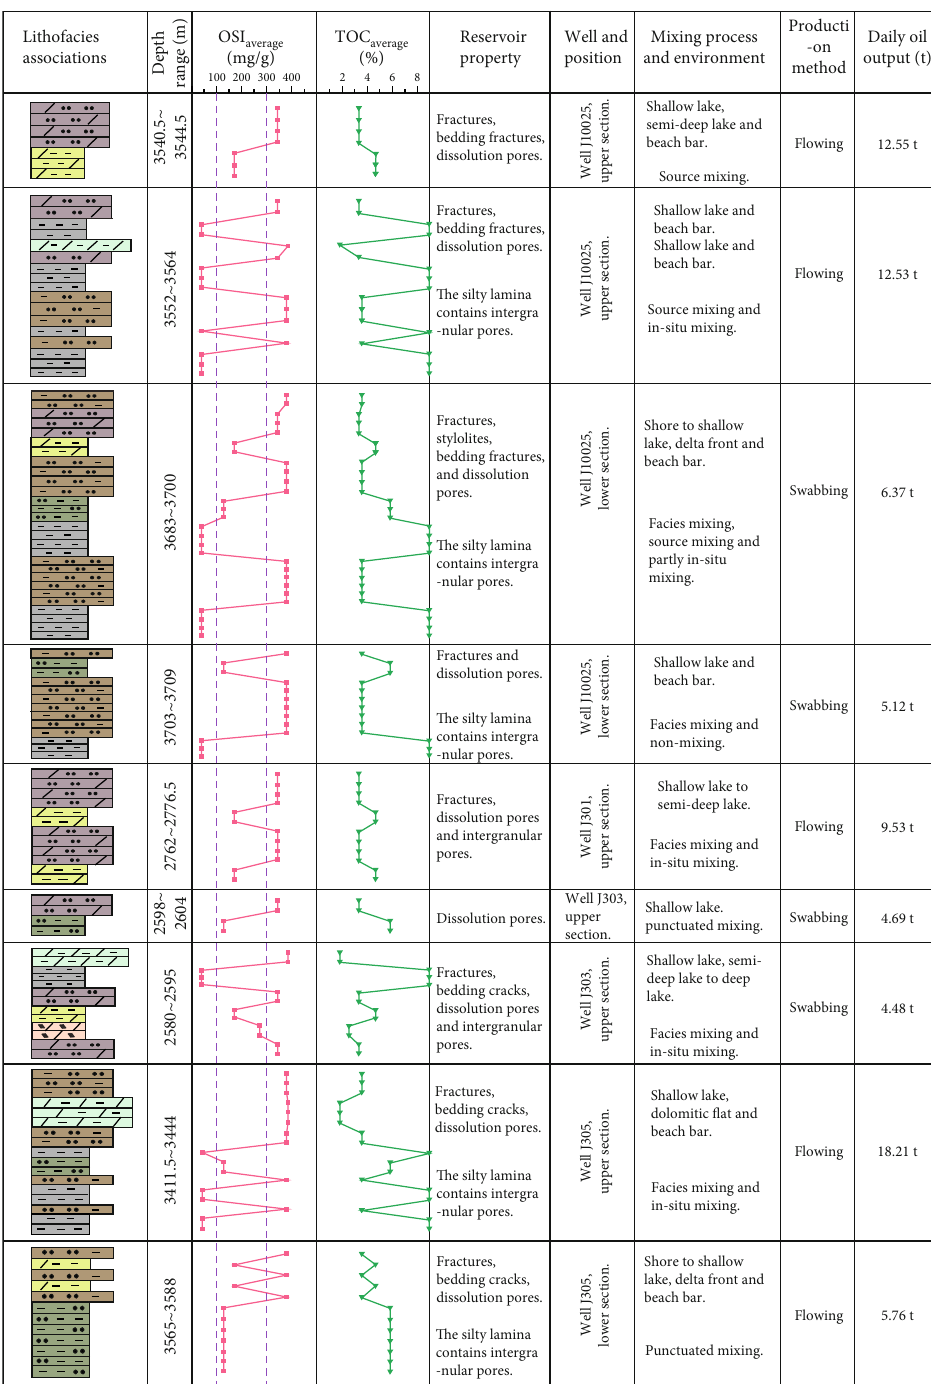
Figure 14: Comprehensive analysis of the mixing processes, lithofacies associations, and production methods in the high-yield sections of the Lucaogou Formation, Jimusar